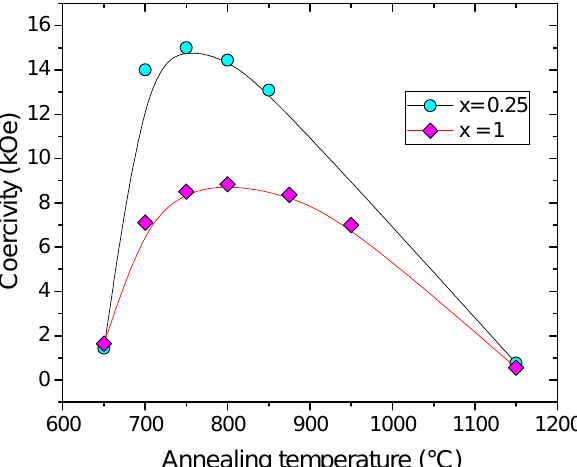
Figure 12. Room temperature coercivity vs annealing temperature for SmFe 9 − x Si x